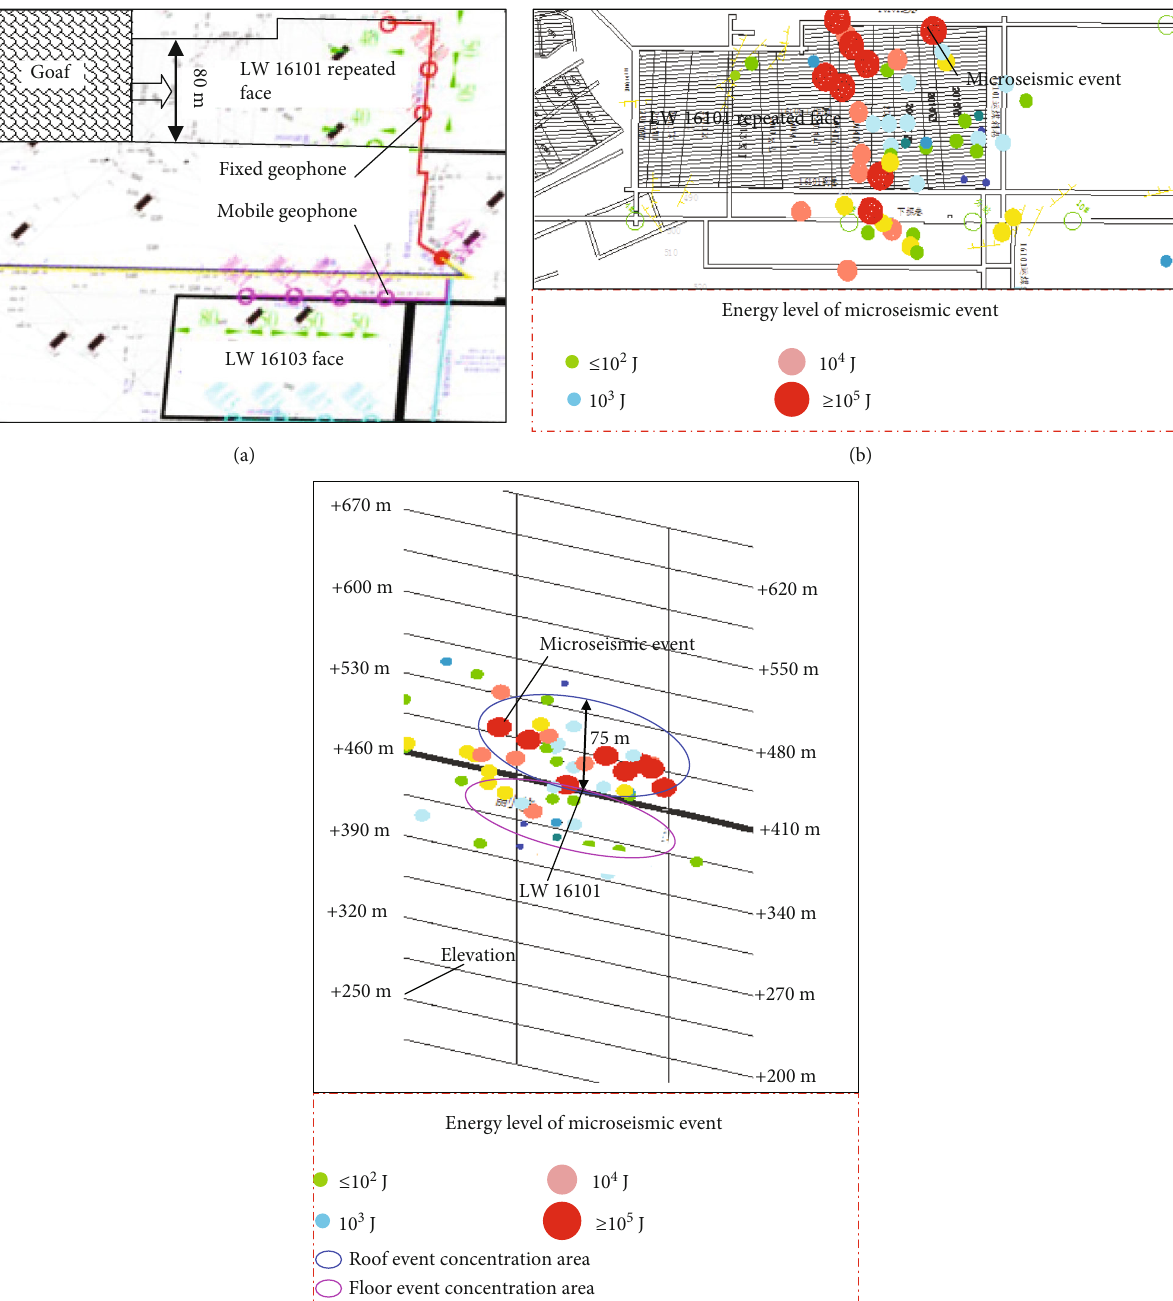
Figure 9: Microseismic monitoring scheme and monitoring results of the Longwall 16101 repeated face: (a) Layout of underground microseismic measuring points; (b) Plan of microseismic event; (c) Pro fi le of microseismic